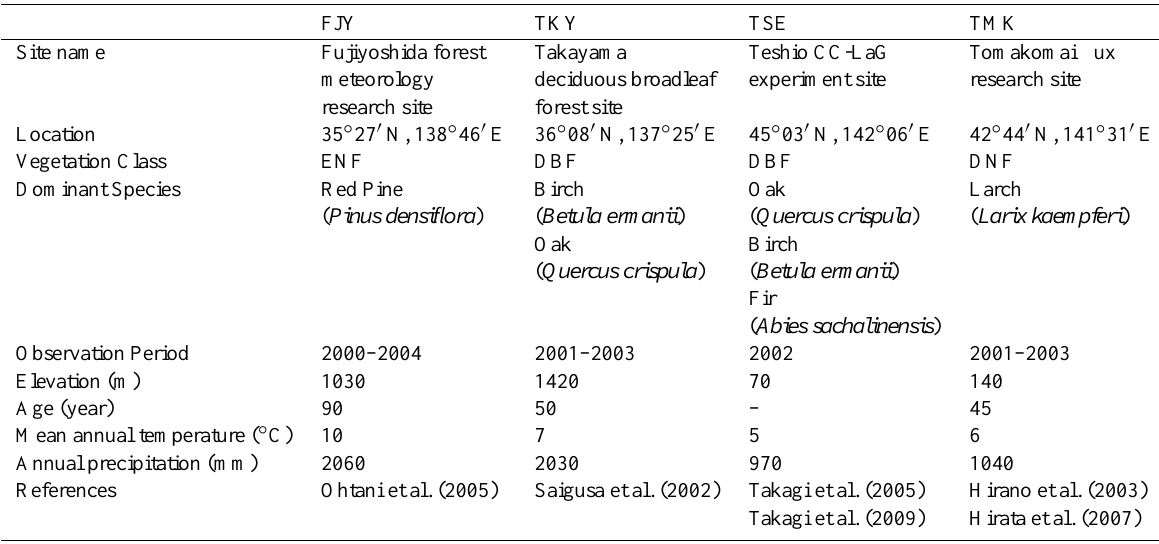
Table 1. Eddy flux observation sites used in this study.